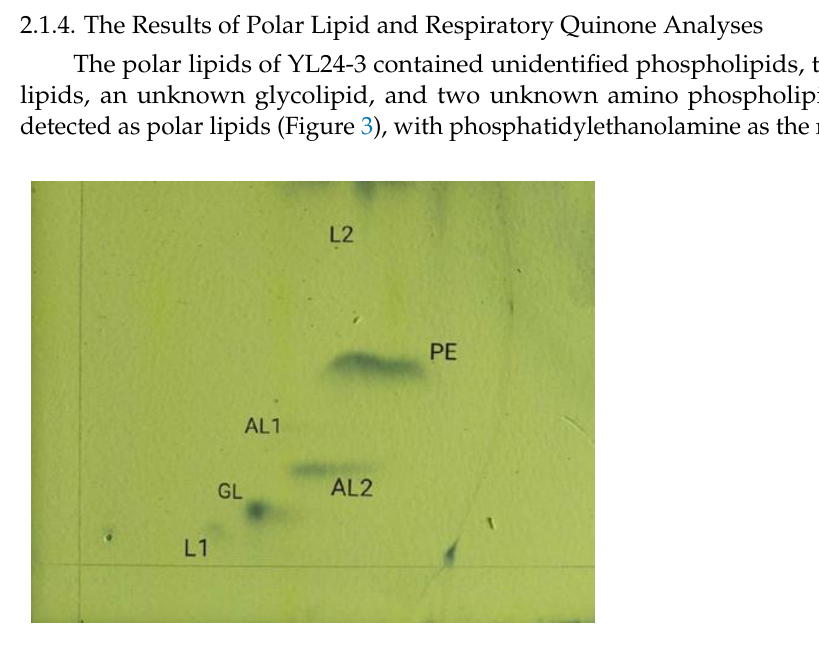
Figure 3. Two-dimensional thin-layer chromatography of polar lipids of strain YL24-3. PE: phos- phatidylethanolamine; GL: glycolipid; AL: amino phospholipid; L: unidentified lipids. phatidylethanolamine; GL: glycolipid; AL: amino phospholipid; L: unidentified